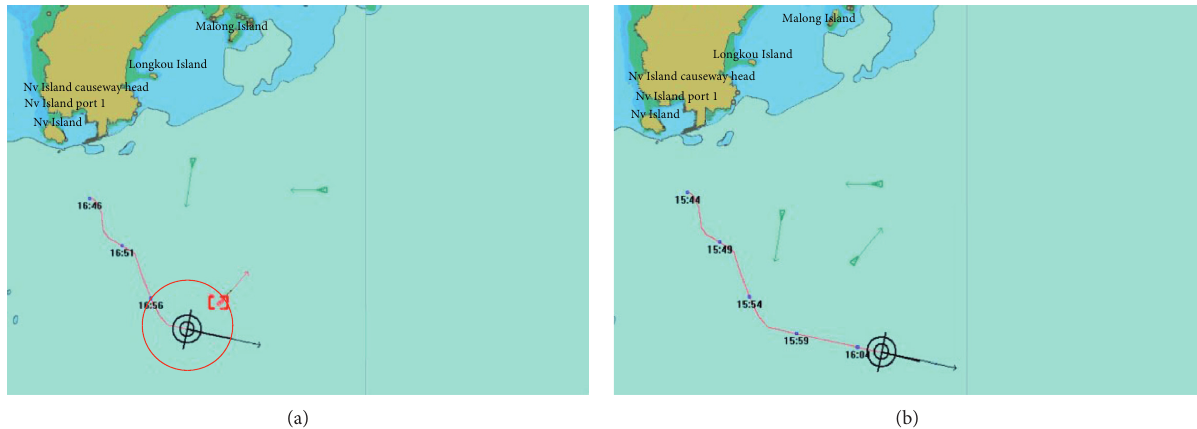
Figure 33: Picture of the end of own ship avoidance. (a) Location map of own ship after evading Ship-2. (b) End of own ship